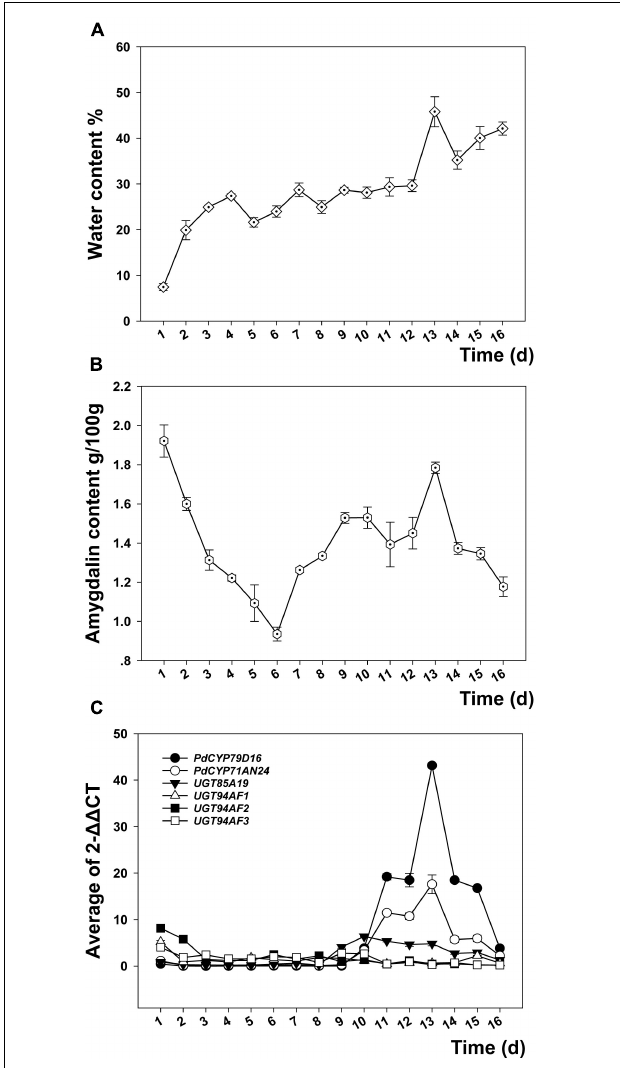
FIGURE 6 | Changes in the water content (A) , amygdalin content (B) , and expression of key regulatory genes (C) in kernels of longstalk almond during the process of seed germination promoted by water